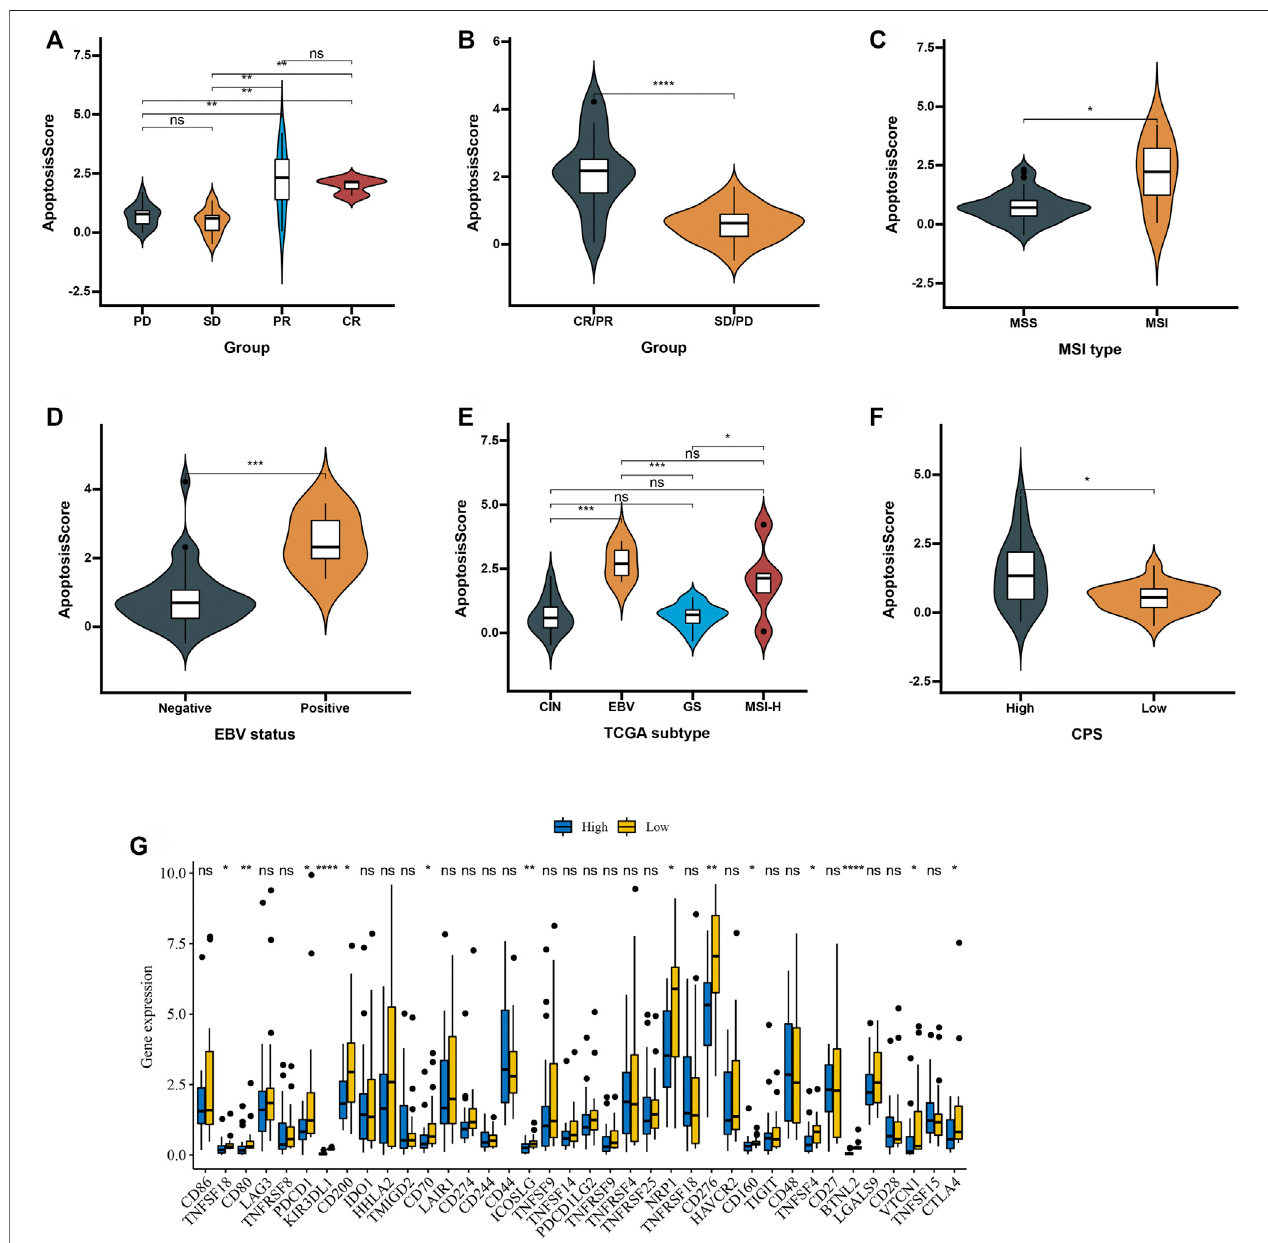
FIGURE9| Patient characteristics and apoptosisScoreofadvancedgastriccancertreated withanti-PD-1immmunotherapy. (A) DistributionofapoptosisScore in distinct anti-PD-L1 clinical response groups. (B) Differences in apoptosisScore among distinct anti-PD-1 clinical response groups. (C) Differences in apoptosisScore between MSI type. (D) Differences in apoptosisScore between EBV status. (E) Differences in apoptosisScore between TCGA subtypes. (F) Differences in apoptosisScore between high and low CPS score groups. (G) Differences in checkpoint expression between low and high apoptosisScore groups in advanced gastric cancer treated with anti-PD-1